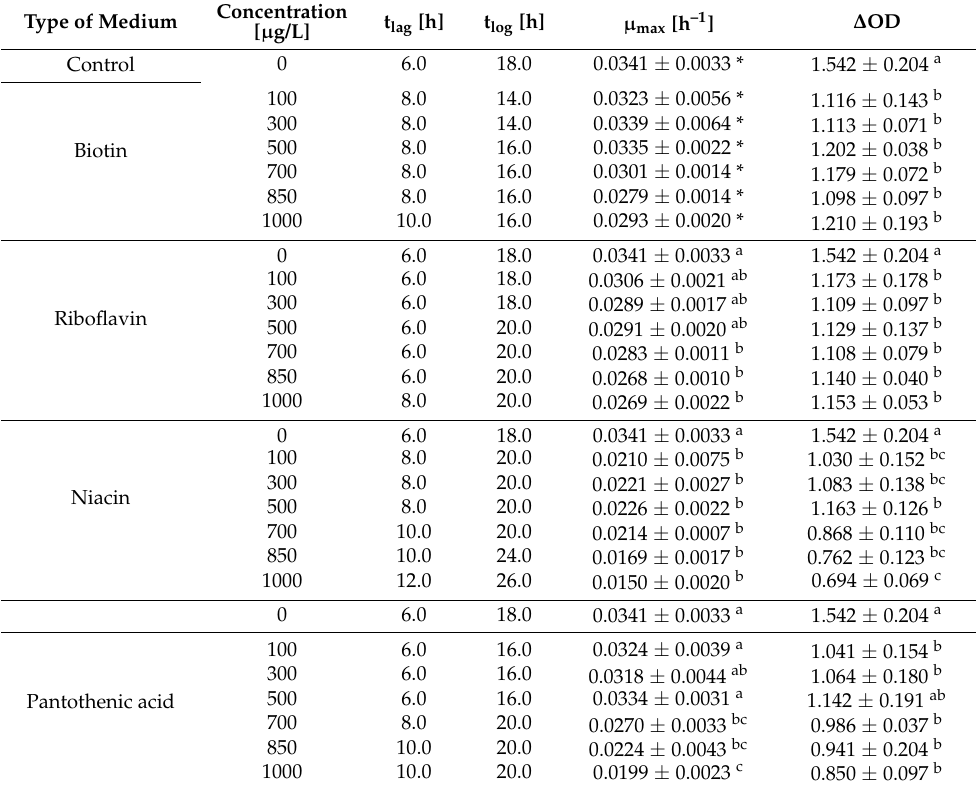
Table 2. Characteristics of Rhodotorula mucilaginosa MK1 yeast observed in Bioscreen C during cultivation in media supplemented with B